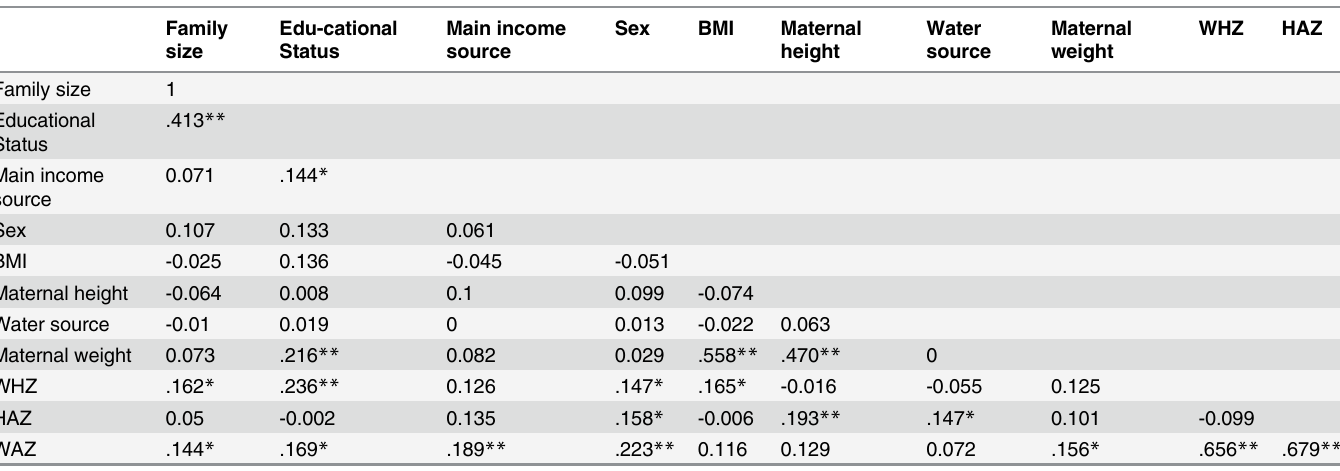
Table 3. Pearson correlation coefficient for mother-child variables (n =